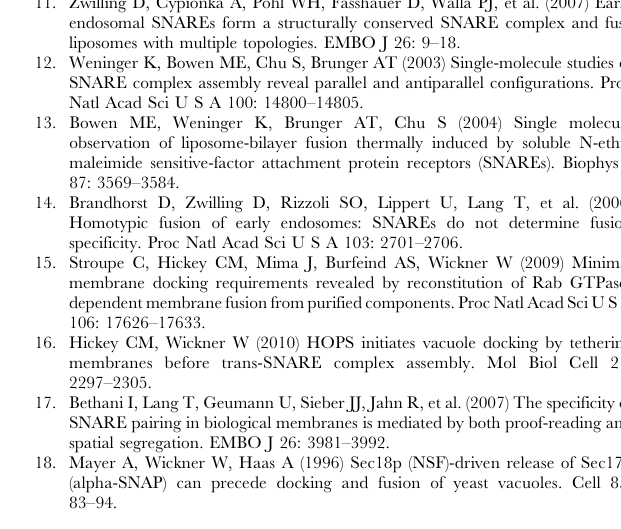
Figure S8 rSec18 influence on vacuolar fusion at different concentrations. Vacuoles from wildtype cells (BJ&DKY) or vtc4 D (BJ&DKY) were incubated under fusion conditions in the presence or absence of ATP and rSec18. Recombinant Sec18 was added at increasing concentration ranging from 1 m g/ml up to 40 m g/ml. As a buffer control, rSec18 samples were heat inactivated, and the remaining supernatant added to the fusion reaction with the same volume as active rSec18. After 60 min of incubation at 27 u C fusion, activity was assayed as described in ‘‘Materials and Methods.’’ Figure S9 Influence of oxidation on the persisting Q bc R- complex. (A) Nyv1 was precipitated from oxidized and reduced vacuoles or from vacuoles that were oxidized during the isolation procedure but were complemented with DTT in the fusion reaction. In the absence of ATP, Vti1 and Vam7 co-fractionated with Nyv1 under all conditions. ATP addition efficiently separated Vam7 and Vti1 from Nyv1 for the oxidized sample, consistent with published observations. However, the association of Vam7 and Vti1 with Nyv1 persisted even after ATP incubation for the reduced sample. Oxidized vacuoles that had been primed under reducing